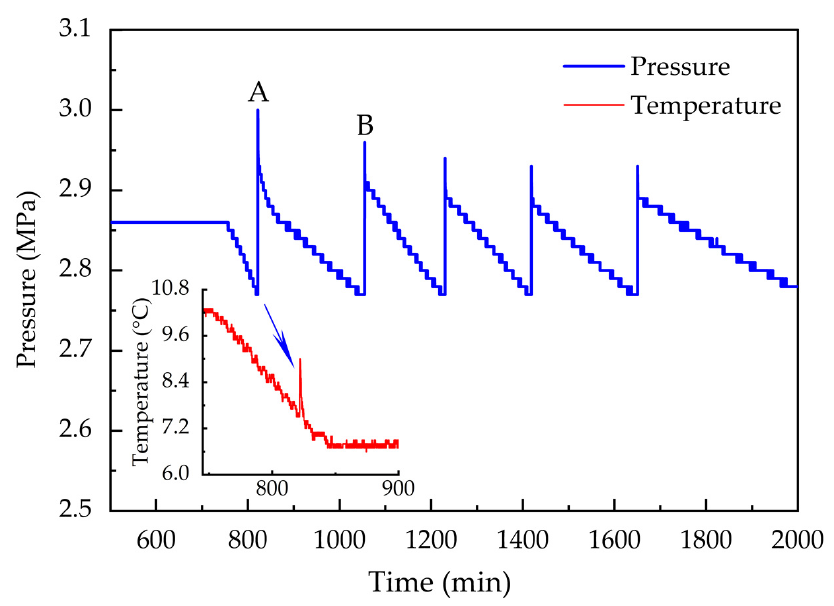
Figure 2. Changes in temperature and pressure during hydrate formation in PW at 6.5 °C . During the dissociation process of the hydrate under atmosphere pressure and room temperature, the flow rates of the released gas were measured by the DGM with the unit L/min. Using the gas state equation, this unit was finally converted into